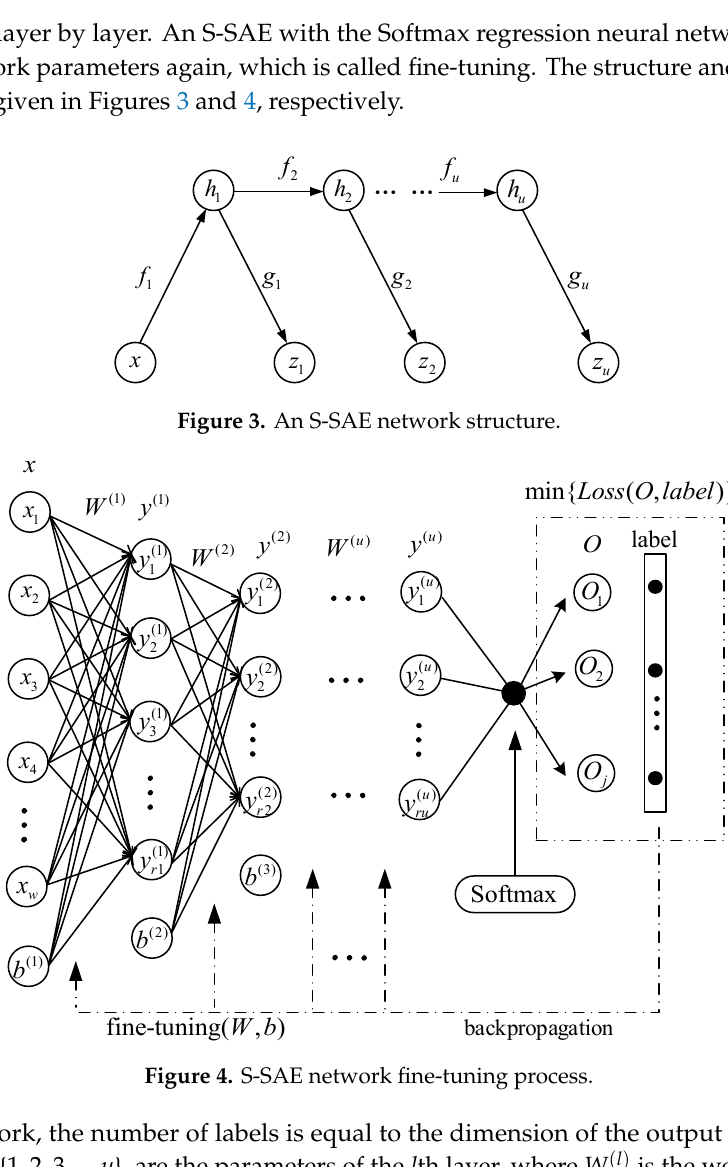
Figure 2. Single-layer auto-encoder (AE) network.